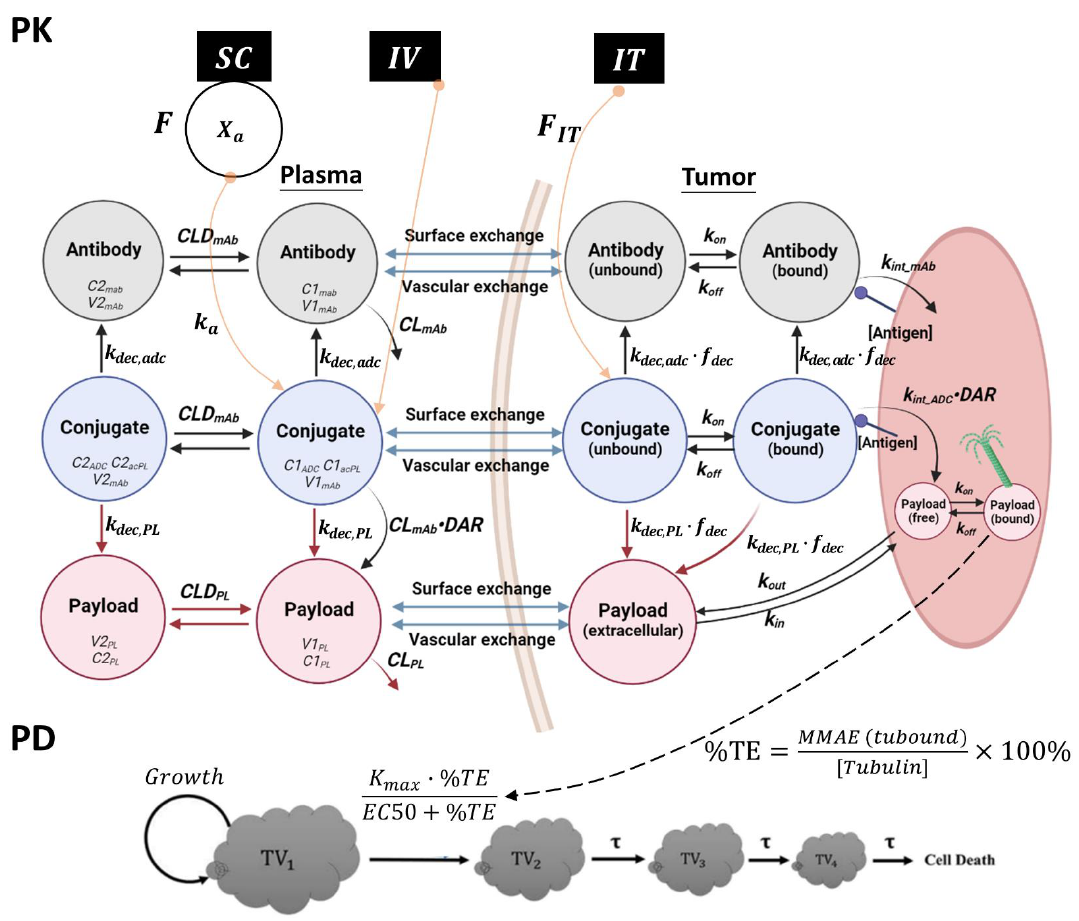
Figure 2. Schematic diagram of the semi-mechanistic PK/PD model developed for IV, IT, and SC administered T-vc-MMAE ADC. The PK model consists of the plasma and tumor PK models connected via vascular (extravasation) and surface exchange (diffusion). The PK model is connected to the PD model using intracellular target engagement (%TE) predicted by the PK model, which is used to drive the efficacy of T-vc-MMAE. Please refer to the PK and PD model structure sections in the method section for a detailed description of the symbols and disposition processes captured by the